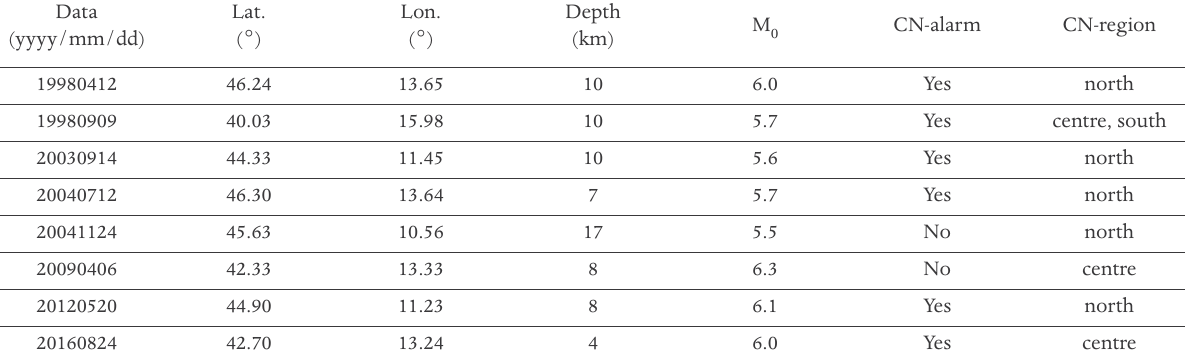
Table 1. Event list related to CN algorithm website (http://www.geoscienze.units.it/esperimento-di-previsione-dei-terremoti-mt/algo- rithm-cn-in-italy.html) for earthquakes occurred in Italy since 1/1/1998 to 08/28/2016 and related parameters. Last two columns indicate if there was a TIP (or not) and the macro-zones related, respectively.